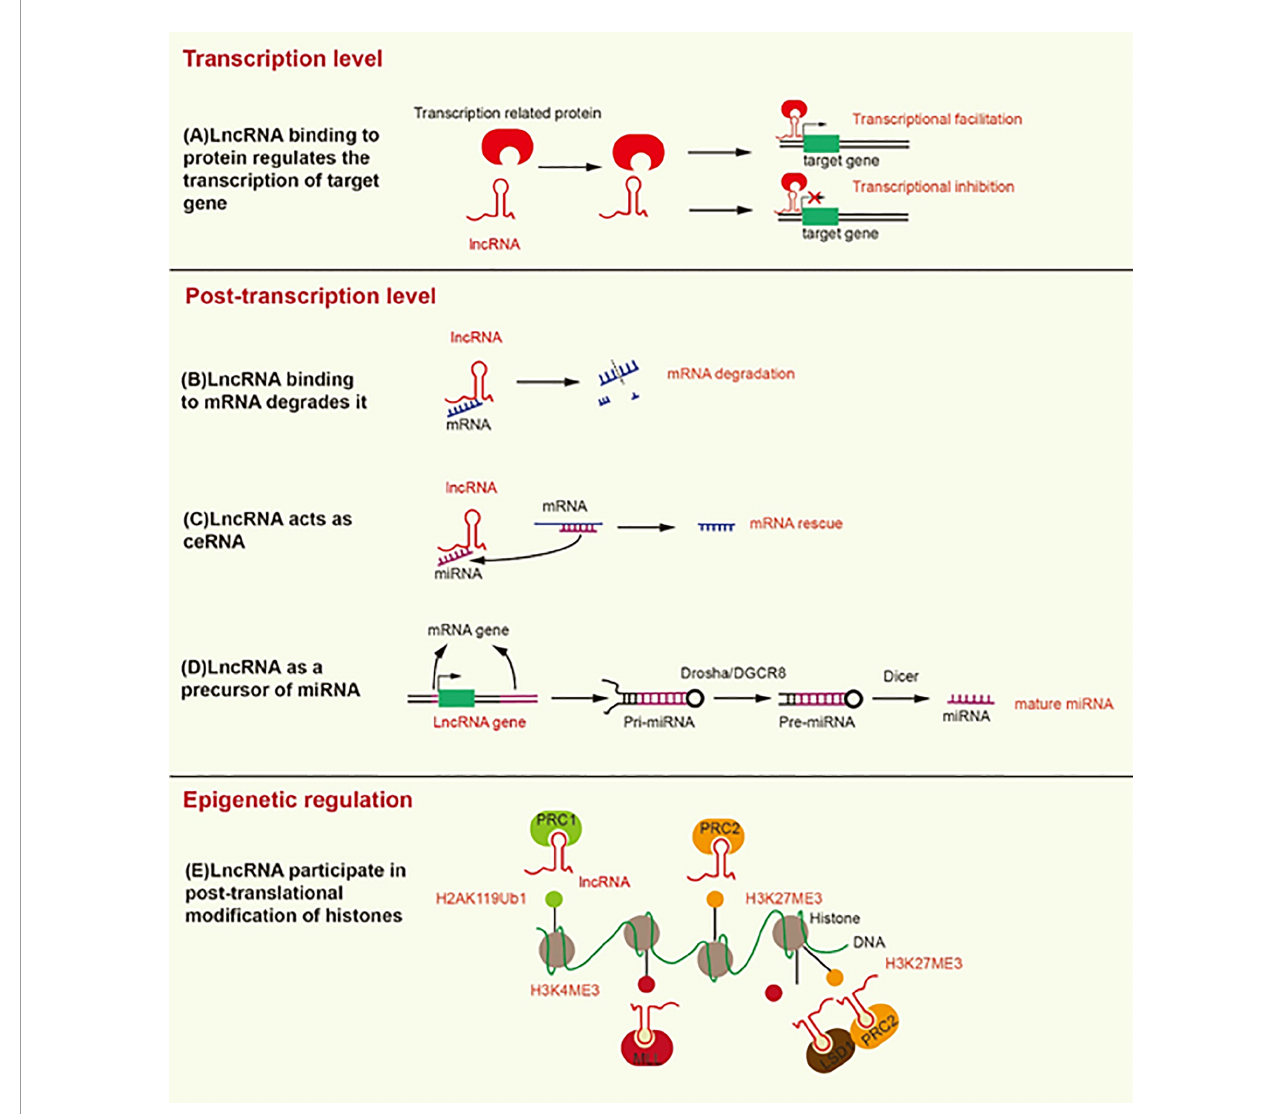
FIGURE 1 | Mechanisms underlying the modi fi cation induced by lncRNA at the transcriptional, post-transcriptional, and epigenetic levels. (A) LncRNA binding to transcription-related proteins mediates transcriptional activation or transcriptional inhibition. (B) LncRNA promotes the degradation of mRNA by recruiting STAU1 to the SBS of dsRNA. (C) LncRNA, as a ceRNA, separates mRNA from its corresponding miRNA target. (D) LncRNA as a precursor of miRNA, develops into mature miRNA under the action of Drosha/DGCR8 and Dicer. (E) LncRNA contributes to the formation of H2AK119Ub1 and H3K27ME3, which inhibit gene transcription. In addition, lncRNA contributes to the formation of H3K4ME3, which promotes gene